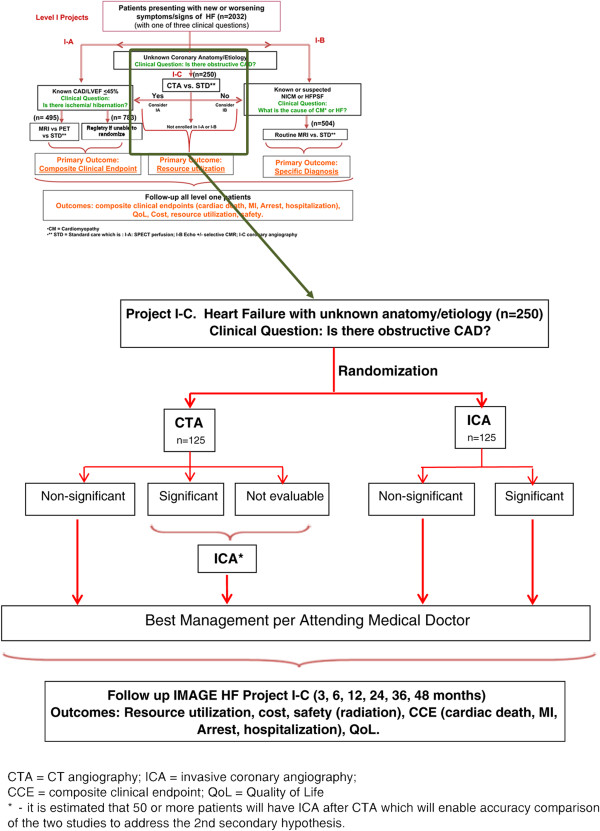
IMAGE-HF Project I-C: experimental algorithm to evaluate use of tomographic coronary angiography (CTA) in determination of heart failure (HF) etiology. Figure 1 illustrates the experimental model of this study, in which the ability of CTA to determine etiology of HF will be compared to that of invasive coronary angiography (ICA). All patients exhibiting HF of unknown etiology will be considered; patients with contraindications to CTA will be excluded.